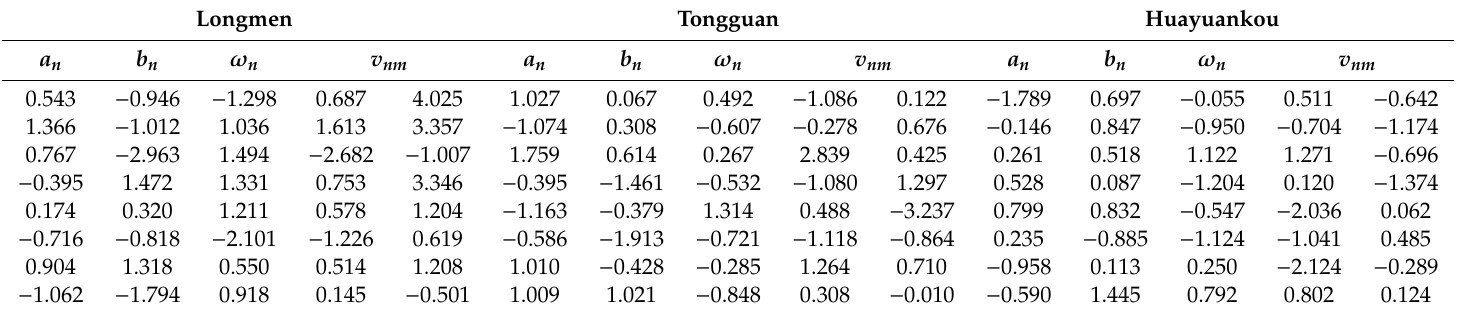
The parameters have the same meaning as Table 8. Table 11. Related parameters of runo ff − SSC cointegration